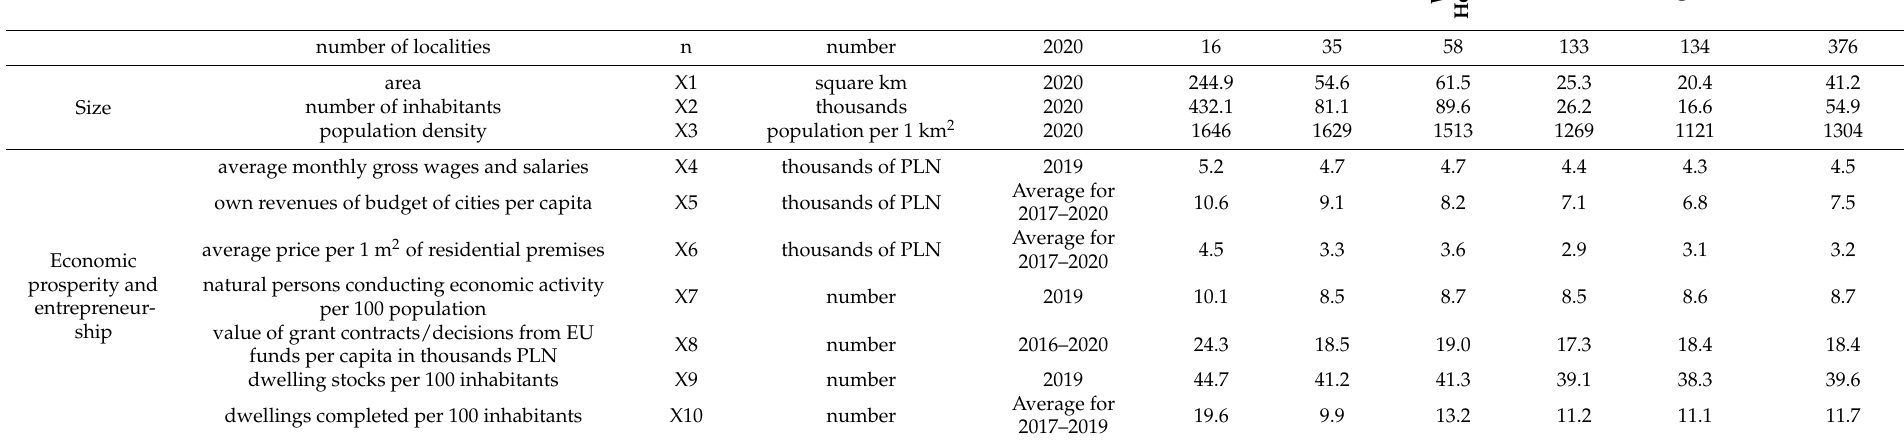
Indicator Unit Year